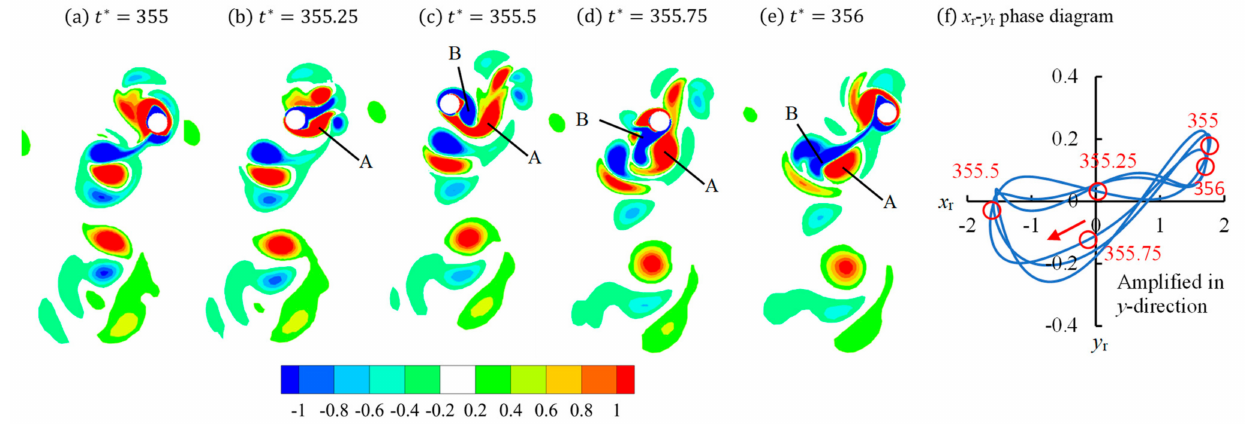
Figure 6. Regime D at β = 45 ◦ , KC = 10, f ∗ = 0.3 within one period starting from t ∗ = 355. ( a – e ) Contours of vorticity of ( f ) x r - y r phase